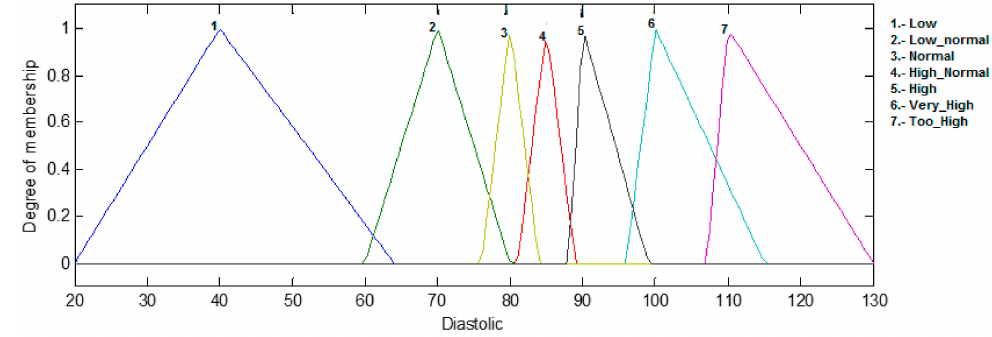
Figure 9. Diastolic input for the fuzzy logic classifier 2.